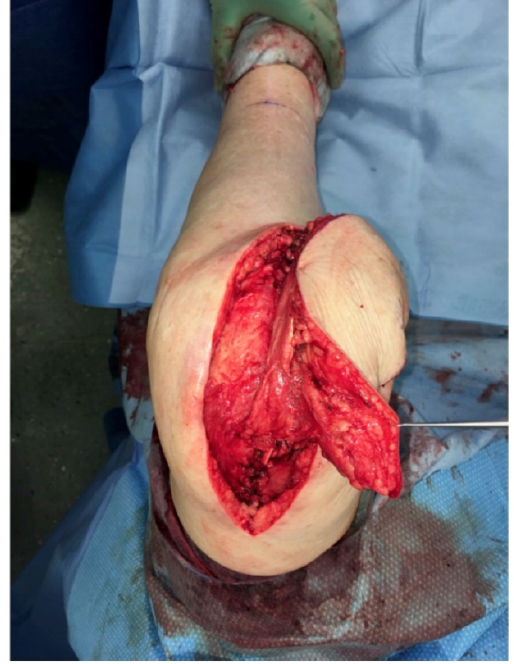
Figure 15: Pedicled MSAP gastrocnemius flap: The tendinous part of the flap is continuously sutured over the medial arthrotomy incision while holding the knee in a flexed position (Table 1: Patient No. 5; additional Figures 6, 12, 13, 14, 16, 17).